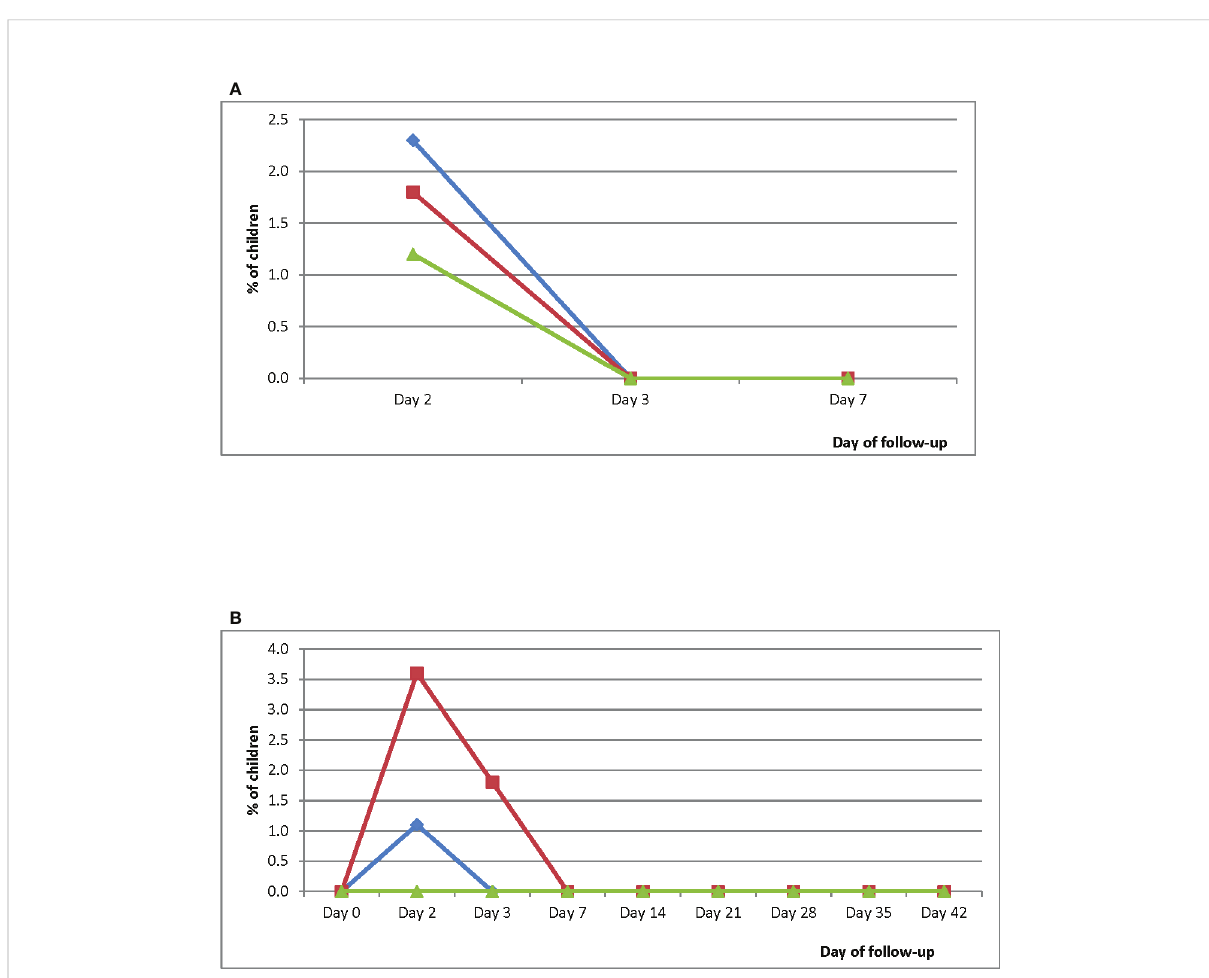
FIGURE 5 (A) Proportion of children with parasitemia during the fi rst week of follow-up. Blue line represents Hohoe Municipal Hospital (HMH); red line represents Ewim Polyclinic (EWP); and green line represents War Memorial Hospital (WMH). (B) Proportion of children with gametocytemia during the 42-day follow-up period. Blue line represents Hohoe Municipal Hospital (HMH); red line represents Ewim Polyclinic (EWP); and green line represents War Memorial Hospital